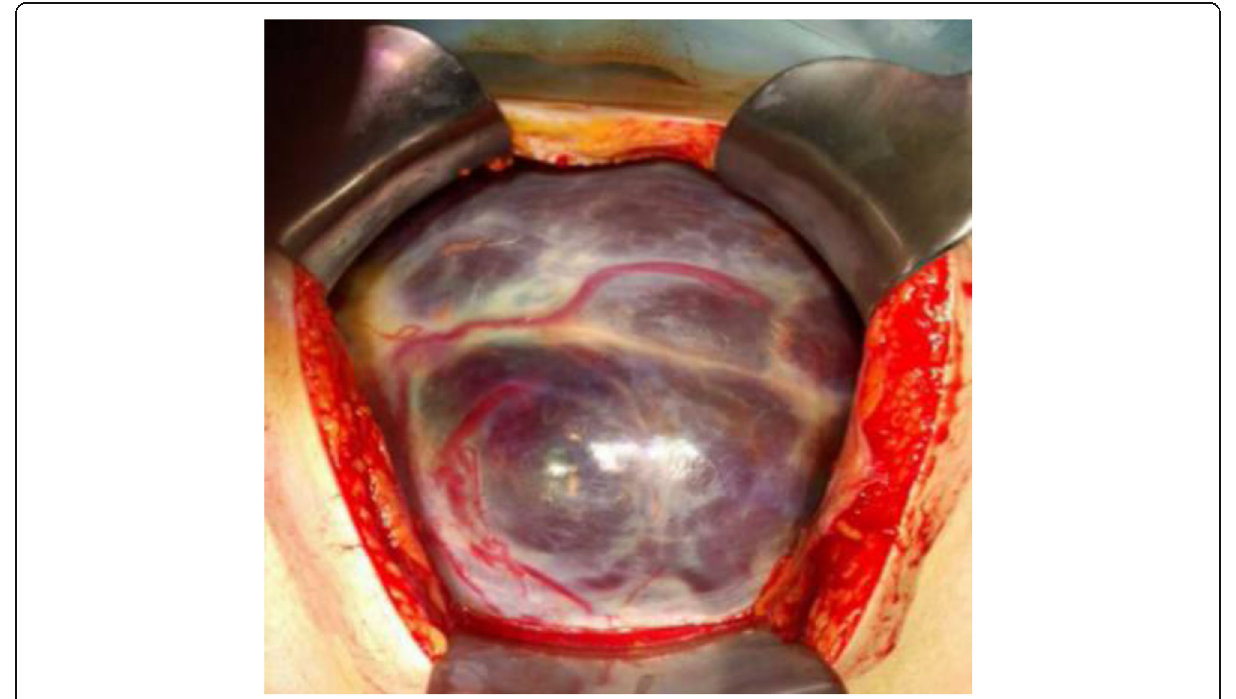
Fig. 1 Uterus with placenta accreta visible at the time of laparotomy. The placenta was bulging through a thin myometrium on the anterior uterine wall. A massive placenta covers the anterior uterine wall with increased vascularity. The fetus was delivered through the